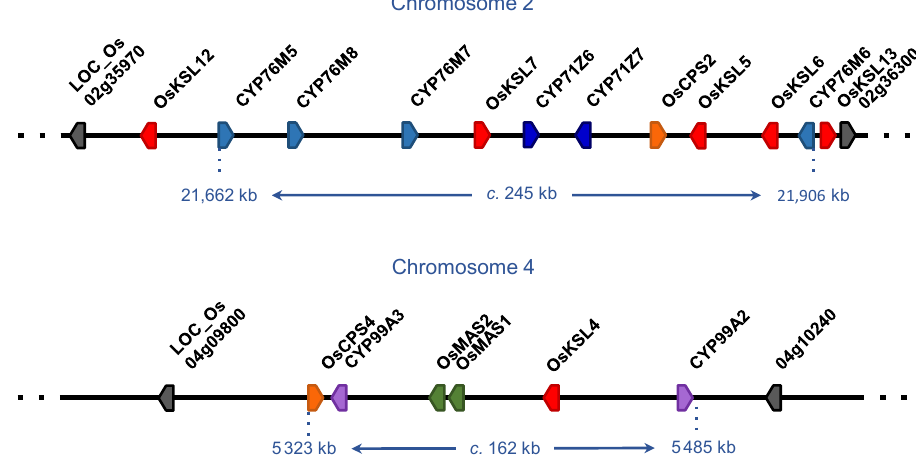
Figure 7. Schematic diagram of loci corresponding to genes involved in diterpene biosynthesis in rice. The biosynthetic gene clusters on chromosome 2 (c2BGC) and chromosome 4 (c4BGC) are located between LOC_Os02g35970 and LOC_Os02g36300 and between LOC_Os04g09800 and LOC_Os04g10240, respectively (adapted from [44,119,126]).